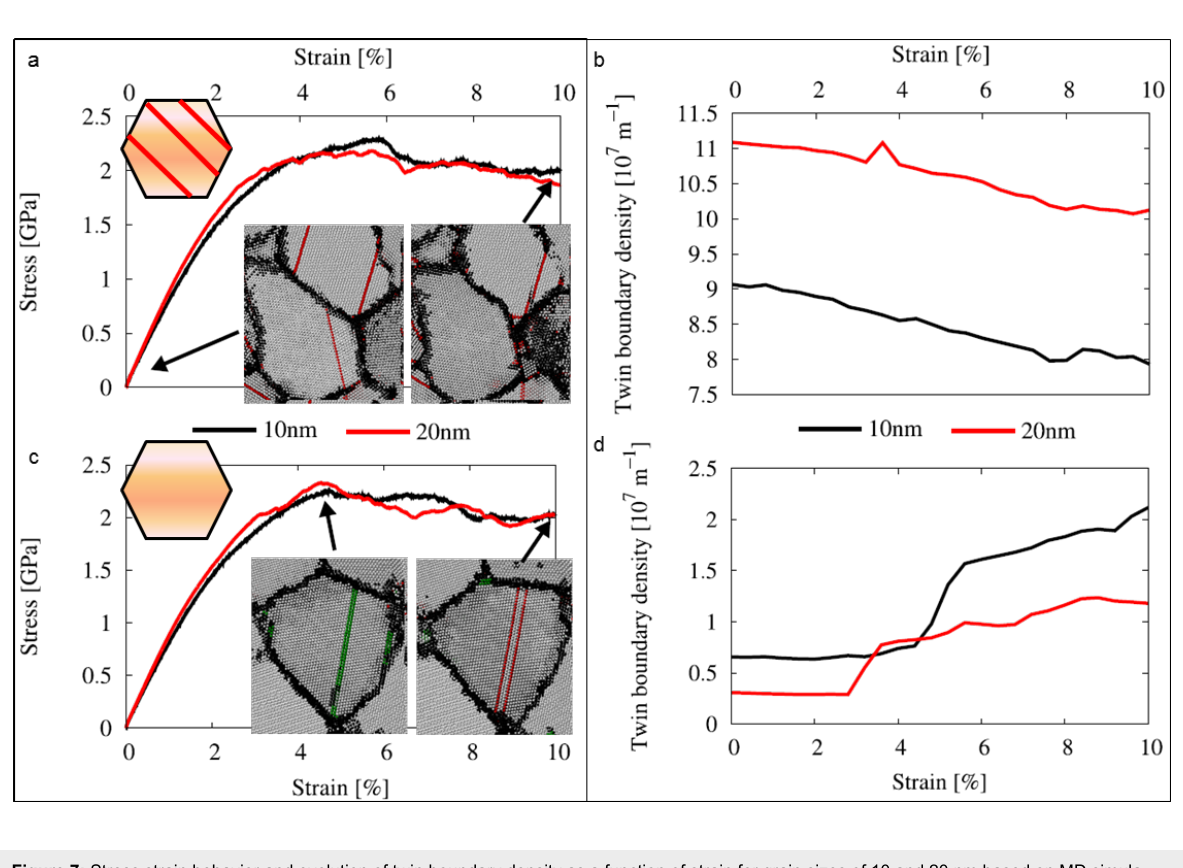
Figure 7: Stress strain behavior and evolution of twin boundary density as a function of strain for grain sizes of 10 and 20 nm based on MD simula- tions. Two different initial microstructures are compared: a) and b) show the data for structures initially loaded with growth twins (50% of the grains are loaded with twin boundaries) and c) and d) without twin boundaries present prior to straining. The snapshots show representative slices through the microstructure at different stages of the deformation. Atoms in the grain boundary are highlighted in black and atoms located in a stacking fault or a twin boundary are highlighted in green and